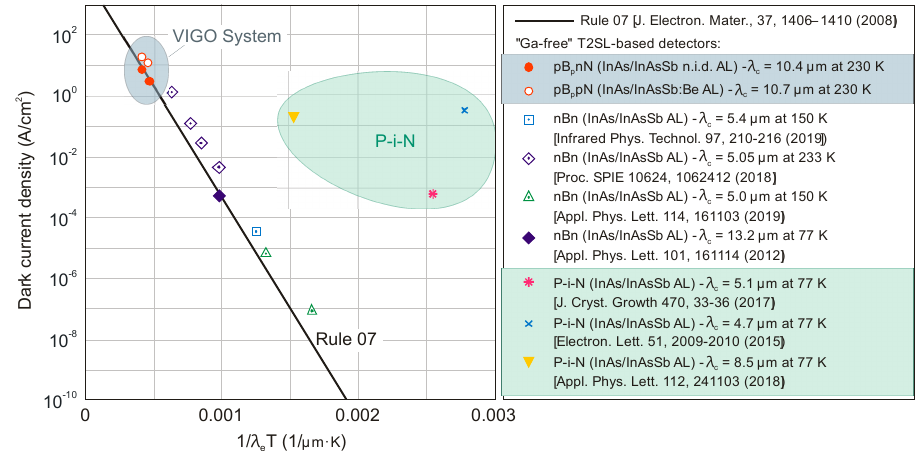
Figure 68. Comparison of various types Ga-free InAs/InAsSb SL detectors with the “Rule 07”.